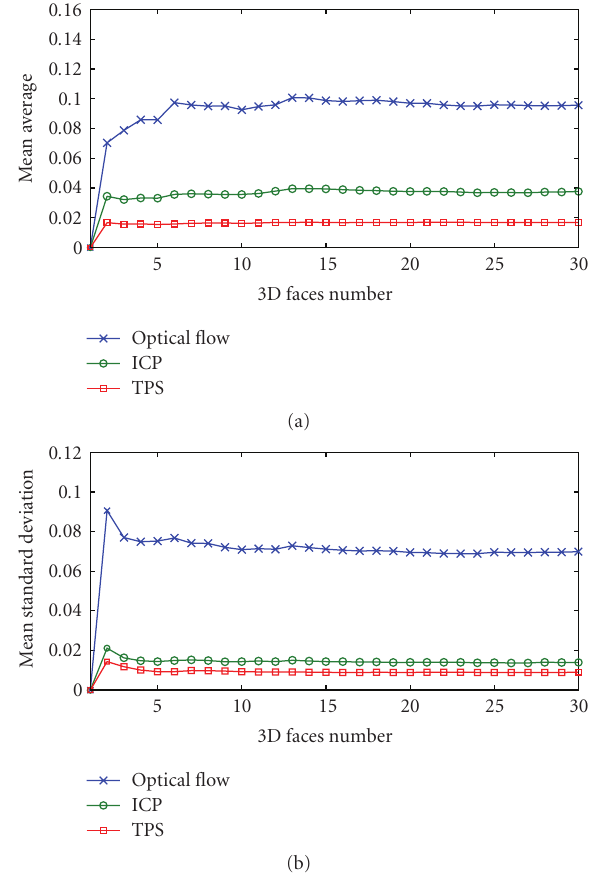
Figure 6: The trend of the mean average and standard deviation of the distances between the correspondent points of the 3D faces in the aligning set with 3D faces number increasing. The top is the mean average of the distances. The bottom is the mean standard deviation of the